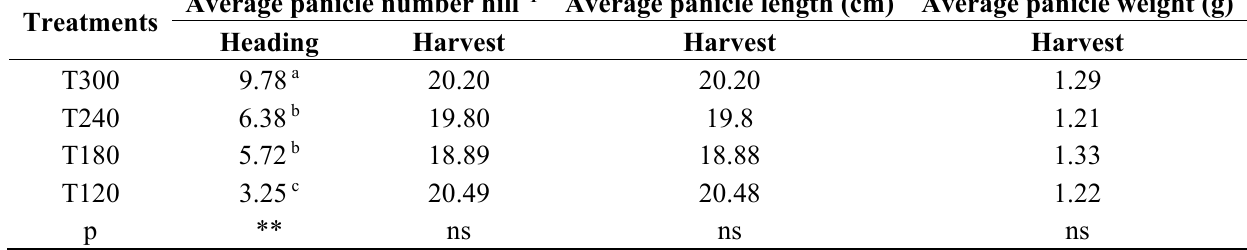
Table 2. Water restriction effects on panicles